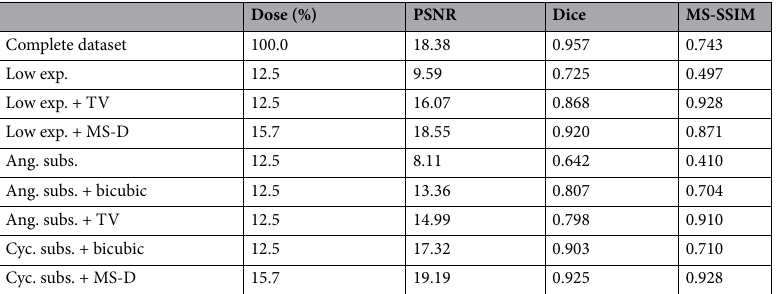
Table 1. Quantitative comparison between different subsampling strategies based on the metrics PSNR, Dice and MS-SSIM. Results are given for angular subsampling (Ang. subs.), low exposure time (Low exp.), and cycloidal subsampling (Cyc. subs.), with and without bicubic splines interpolation (bicubic), TV reconstruction (TV), or application of the MS-D CNN (MS-D). For TV reconstructions, the parameter controlling the strength of the TV term was chosen separately for each column, such that the metric of that column is maximized for the central slice.